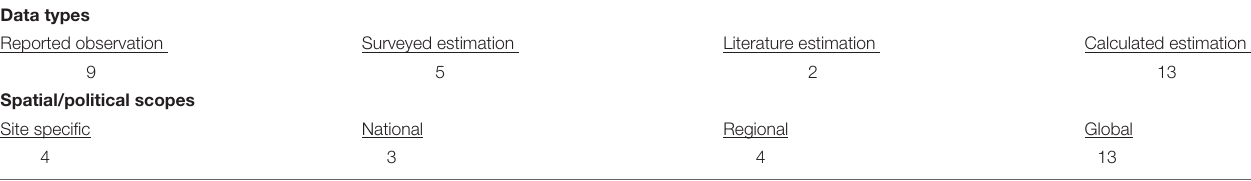
TABLE 3 | Number of articles by data type and geo-political